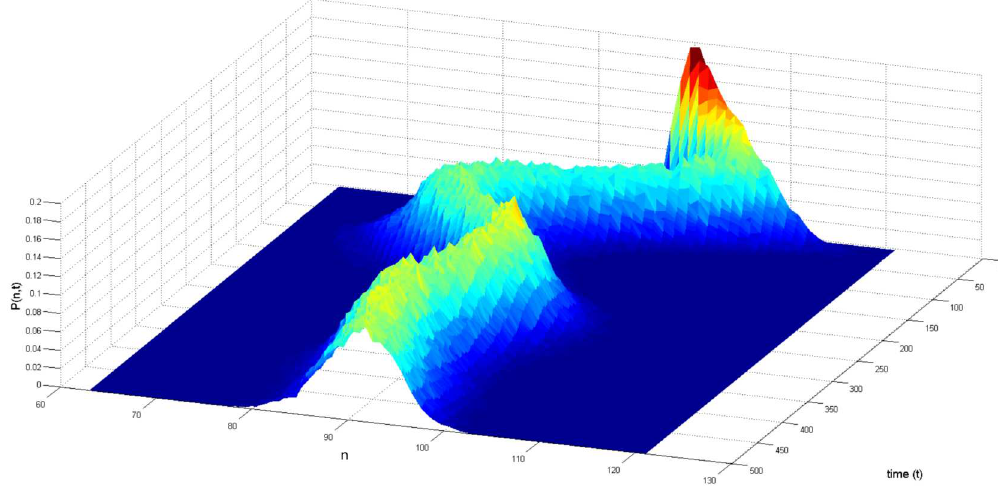
Fig 2. Time-dependent histogram. Time-dependent histogram that estimates the probability P ( n , t ) of obtaining some model output n at time t . The figure was generatedusing 10.000 replicate runs. In this example,the output seems to stabilise as a normal distribution aroundof mean value of n =